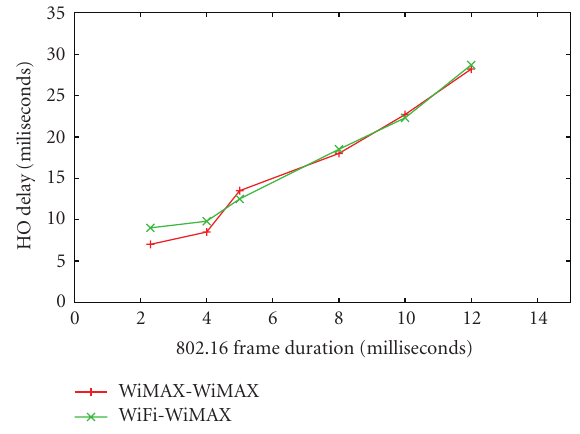
Figure 12: E ff ect of the 802.16 frame duration on optimized HO performances.